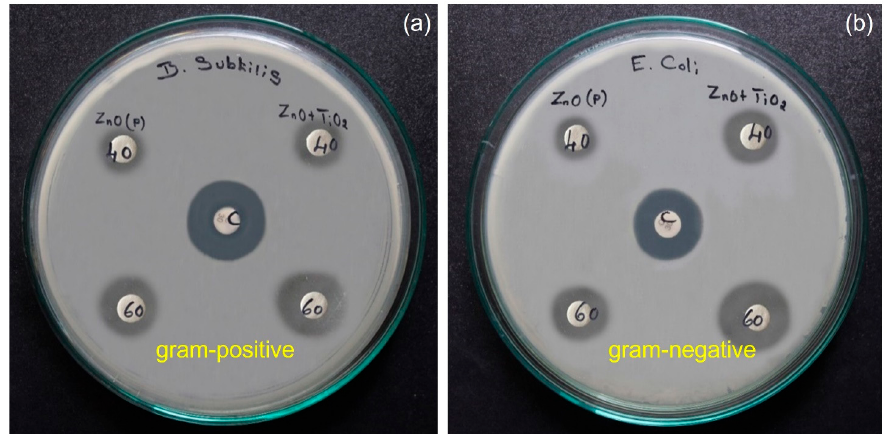
Figure 13. ( a , b ). Bacillus subtilis and Escherichia coli were shown to be susceptible to antibacterial action by pure ZnO and ZnO-doped TiO 2 nanocomposites.